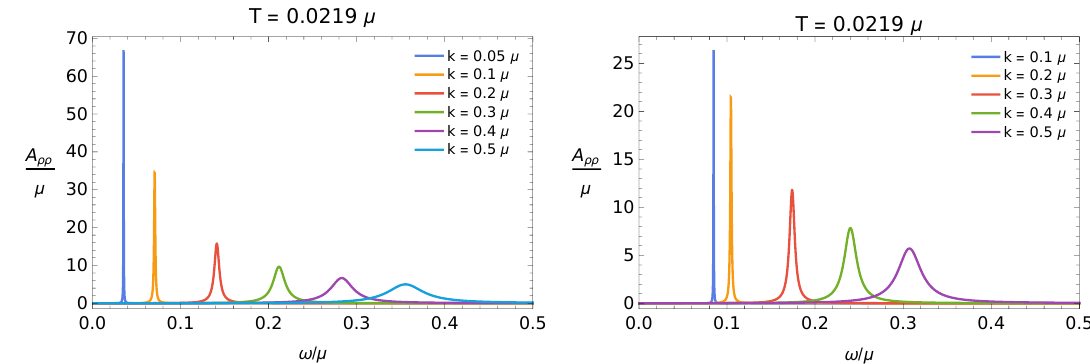
Figure 7. The density spectral function for di(cid:11)erent values of j k j =(cid:22) in the Reissner-Nordstr(cid:127)om solution (left) and with Coulomb corrections (right). We see that due to screening in the charged system the plasmon peaks shift towards higher frequencies and are lower in height than the corre- sponding peak of the sound mode.